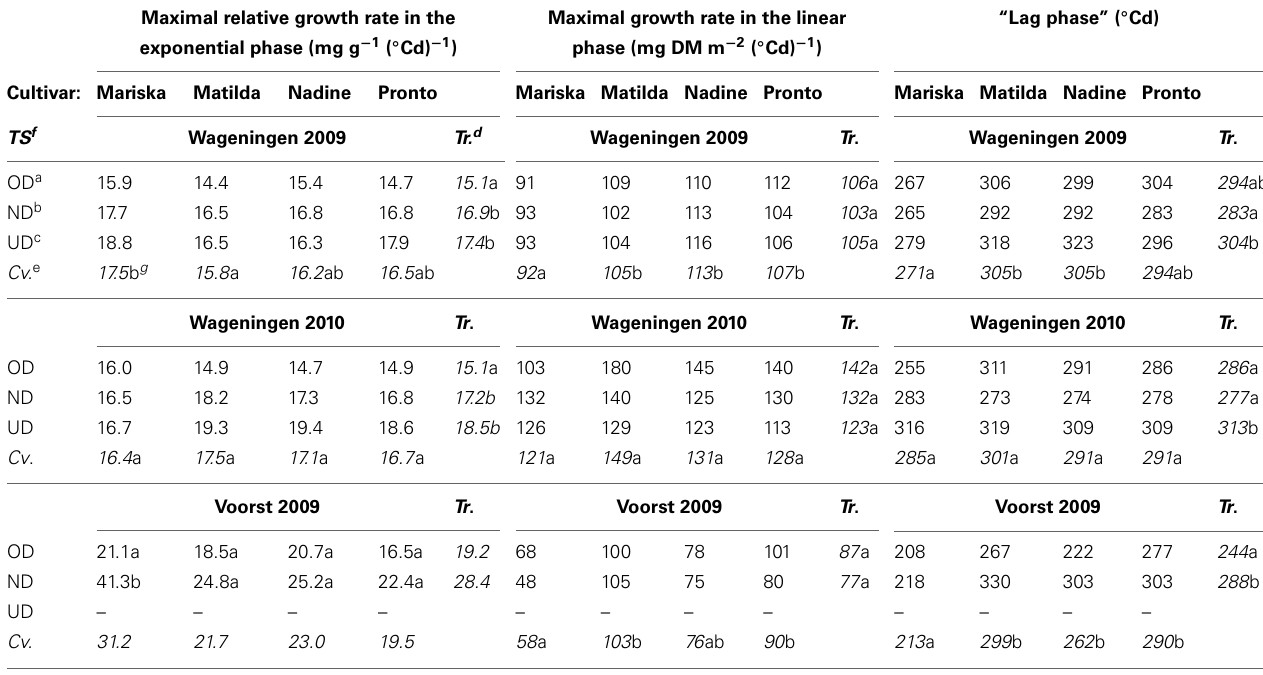
Table 2 | Values for curve fit parameters when applying an expolinear model (Goudriaan and Monteith, 1990) for dry matter accumulation against thermal time, for combinations of transplant sizes and cultivars in each of three experiments. Maximal relative growth rate in